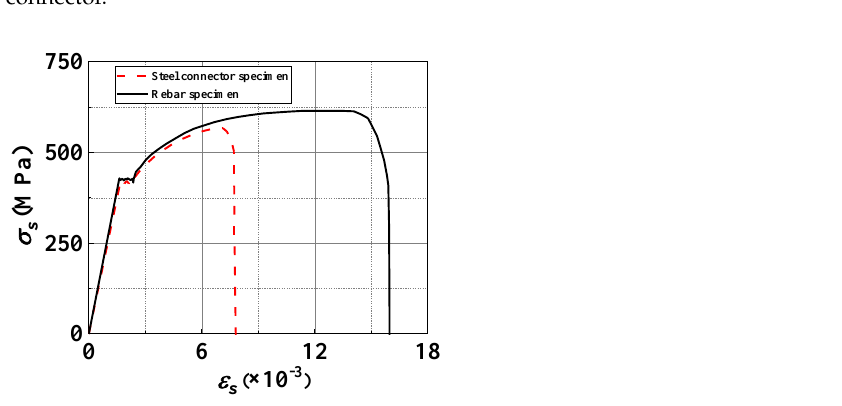
Figure 4. Tensile failure test of steel connector. ( a ) Steel connector. ( b ) Uniaxial tensile test of steel connector.